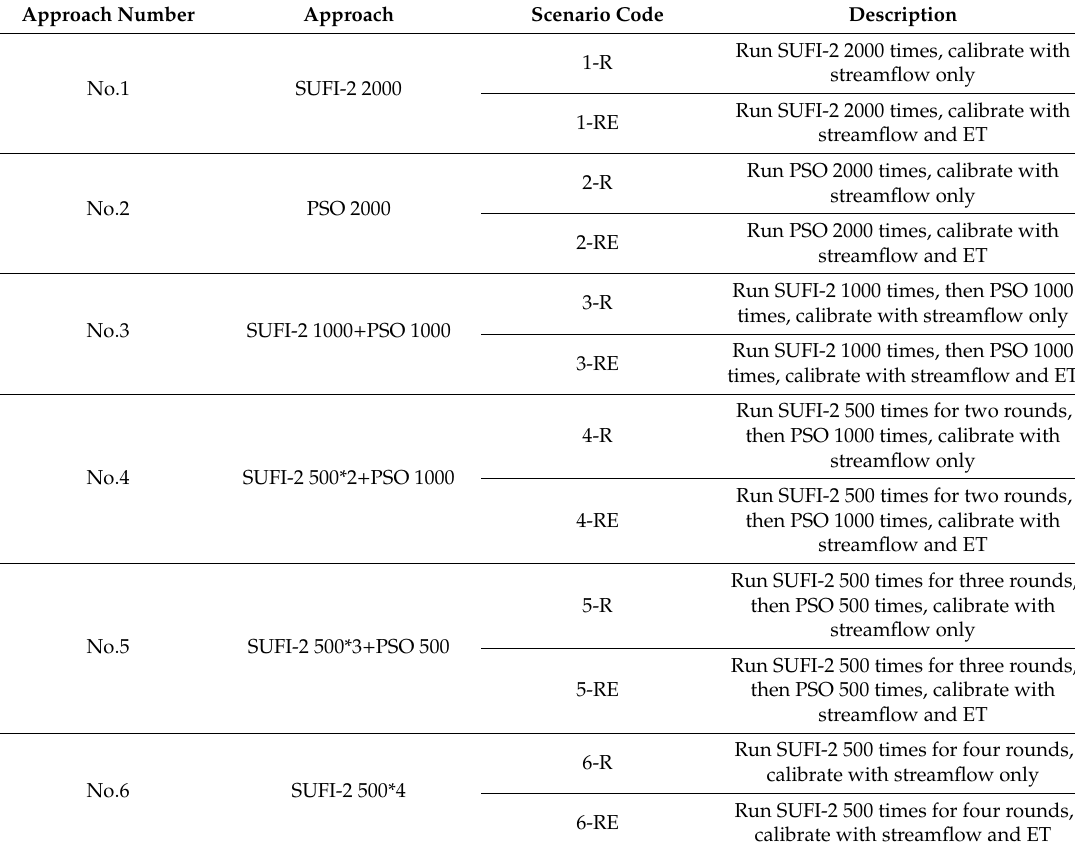
Table 2. Scenario setting of di ff erent